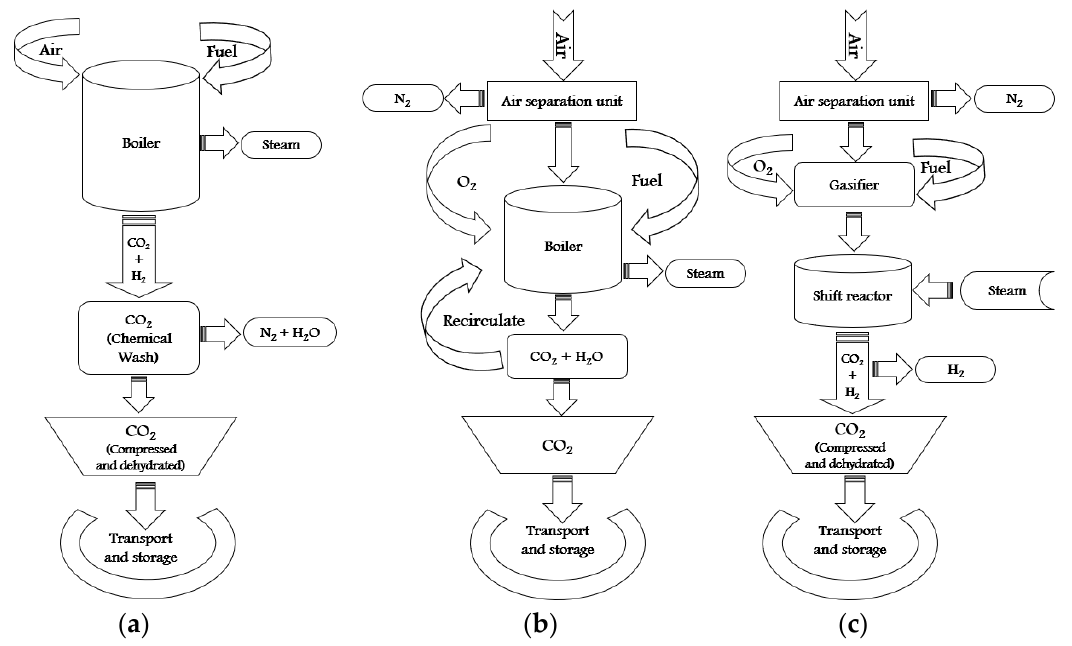
Figure 2. ( a ) The post-combustion capture process, ( b ) oxy-firing process, and ( c ) pre-combustion capture process.